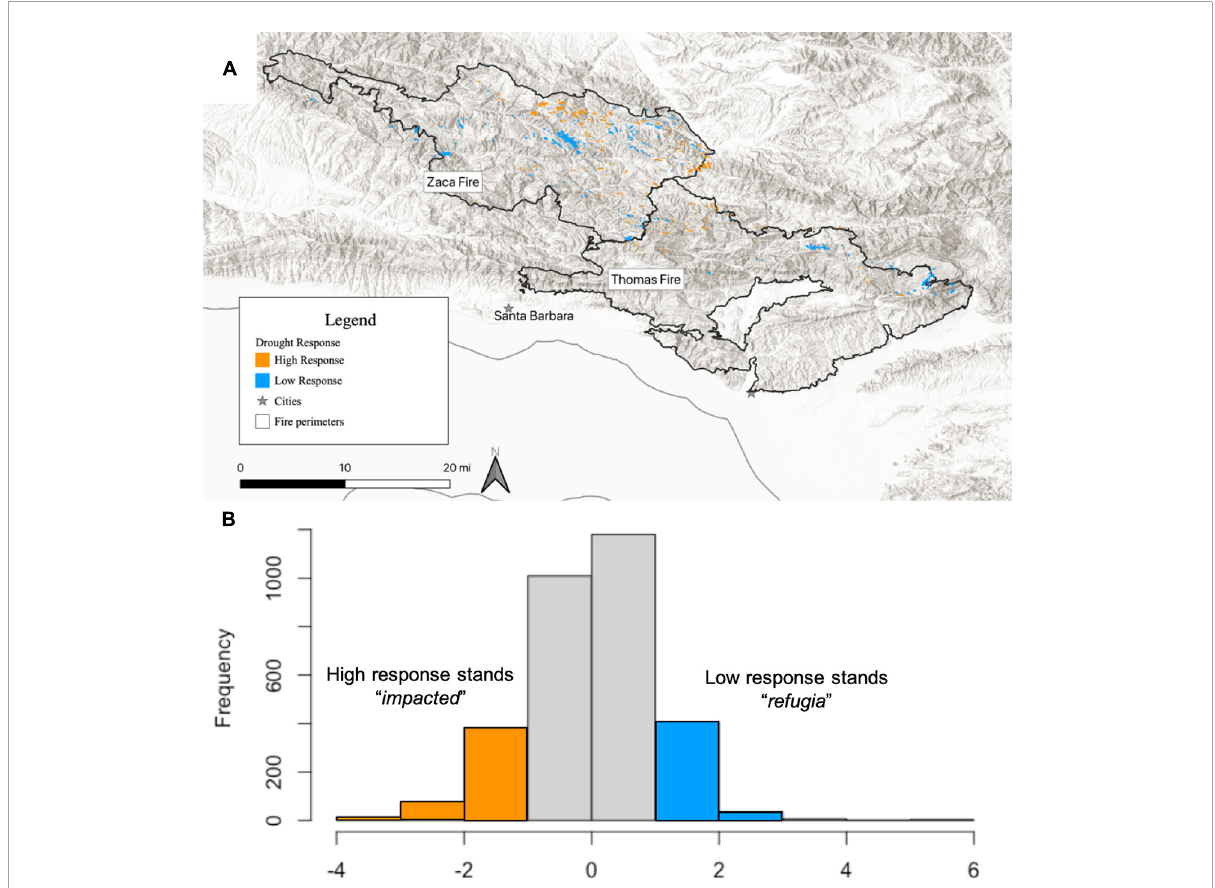
FIGURE3 (A) Map of high and low drought response stands of bigcone (moderate response stands not shown), showing locations of less impacted “refugia” (blue) and highly impacted (orange) stands. (B) Histogram of remotely sensed stand drought response showing categorization of “refugia” and “impacted” stands as those more than 1SD above (more favorable than average) or below (less favorable than average) the mean drought response,